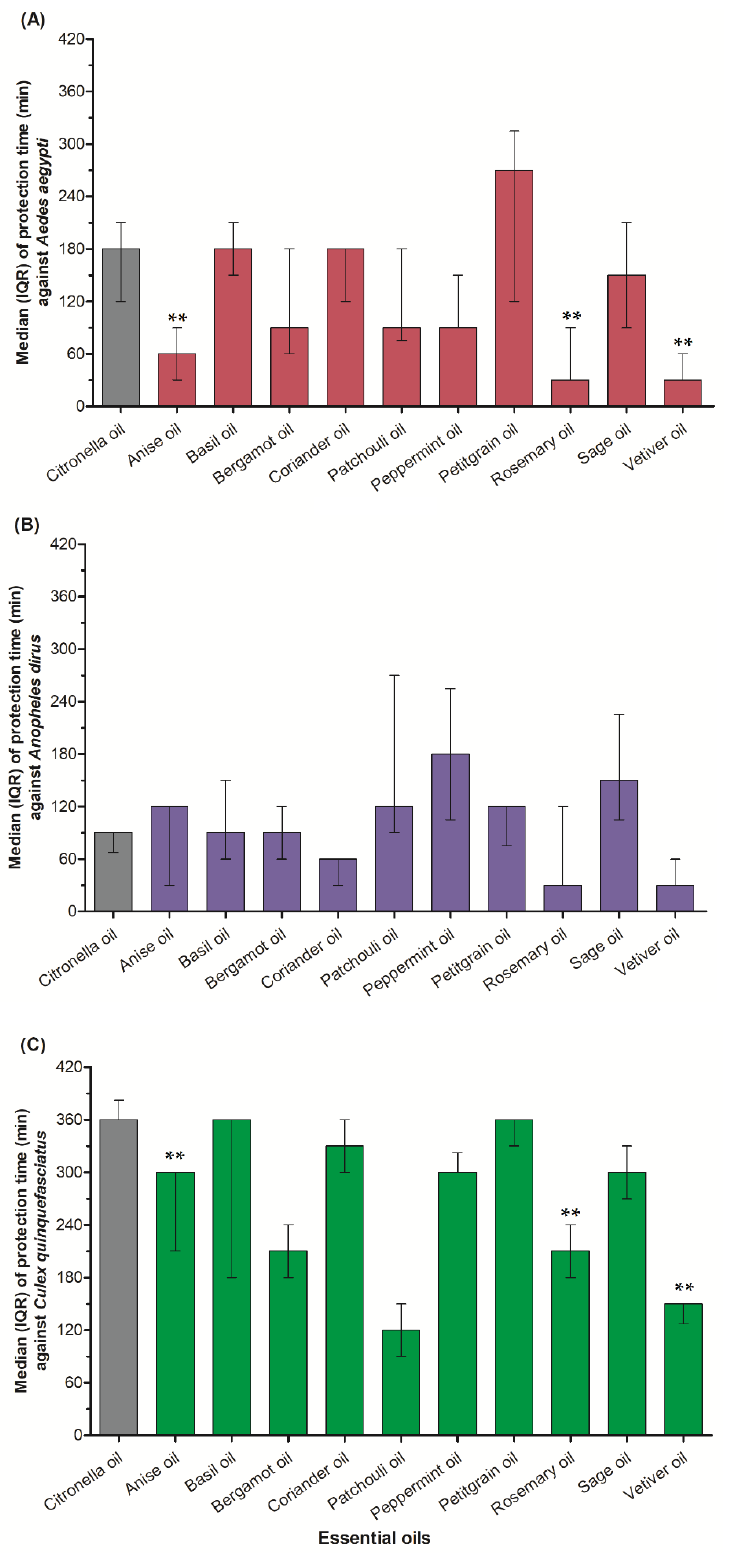
Figure 1. Median with interquartile range (IQR) protection time of 10 undiluted essential oils and citronella (control) against ( A ) Aedes aegypti , ( B ) Anopheles dirus and ( C ) Culex quinquefasciatus . ** Significantly different from control ( p < 0.05).